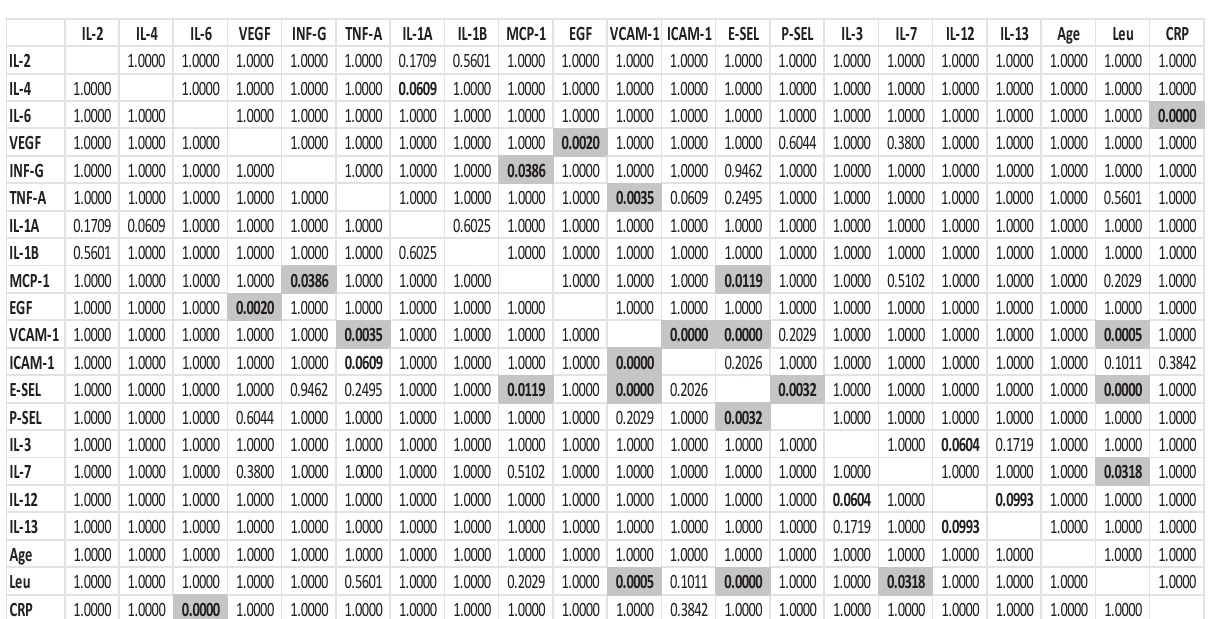
Table 2. Bonferroni-Holm corrected P values of Spearman correlations for cytokines & adhesion molecule levels with age, leukocyte count and CRP. IL-8 and IL-10 not